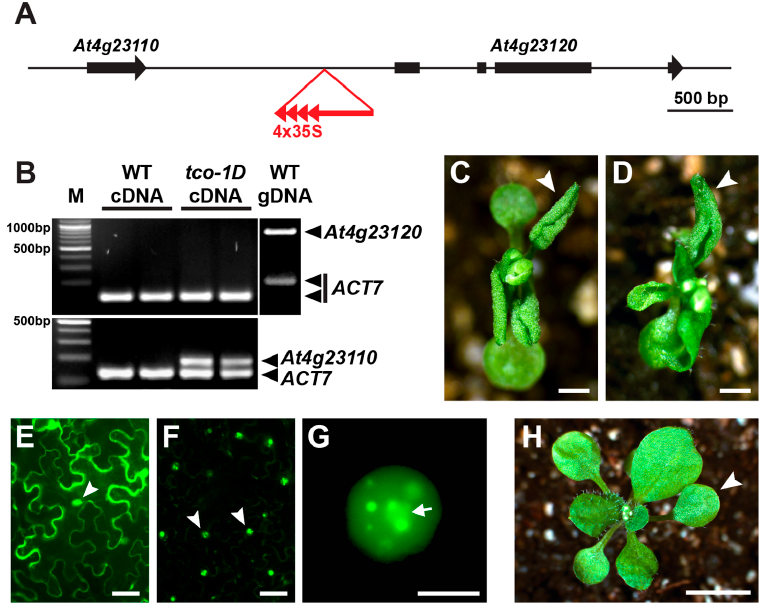
Figure 2. The Arabidopsis gene At4g23110 is overexpressed by the activation-tagging T-DNA in tco-1D . ( A ) Schematic showing the insertion site of the activation-tagging T-DNA (red) in tco-1D between genes At4g23110 and At4g23120 . The 35S enhancer elements (red arrowheads) are oriented upstream. Gene exons are depicted as black rectangles, with black arrowheads showing gene orientation. ( B ) Semi-quantitative reverse transcription-polymerase chain reaction (RT-PCR) assessing the expression of genes At4g23110 (bottom) and At4g23120 (top) in 7 days after germination (DAG) seedlings of tco-1D and wild-type (WT), with ACTIN7 ( ACT7 ) serving as an internal control. Two biological replicates of each RT-PCR reaction are shown. A PCR with WT genomic DNA shows efficient amplification of At4g23120 (top, right). ( C ) tco-1D and ( D ) 2x35Sp::TCO-GFP plants at 19 days after germination (DAG). Note similar curling of first vegetative leaves (arrowheads). ( E – G ) Transient transfections of tobacco leaves. ( E ) 2x35Sp::YFP is localized to the cell nucleus (arrowhead) and cytoplasm. ( F ) 2x35Sp::TCO-GFP localizes to nuclei (arrowheads). ( G ) Close-up of 2x35Sp::TCO-GFP nucleus showing localization in a central subnuclear compartment predicted to be nucleolus (arrow) and in other punctate nuclear foci. ( H ) WT plant at 19 DAG with first vegetative leaf denoted (arrowhead). Bars: ( C , D ) 1 mm; ( E , F ) 50 μ m; ( G ) 10 μ m; ( H ) 5 mm.